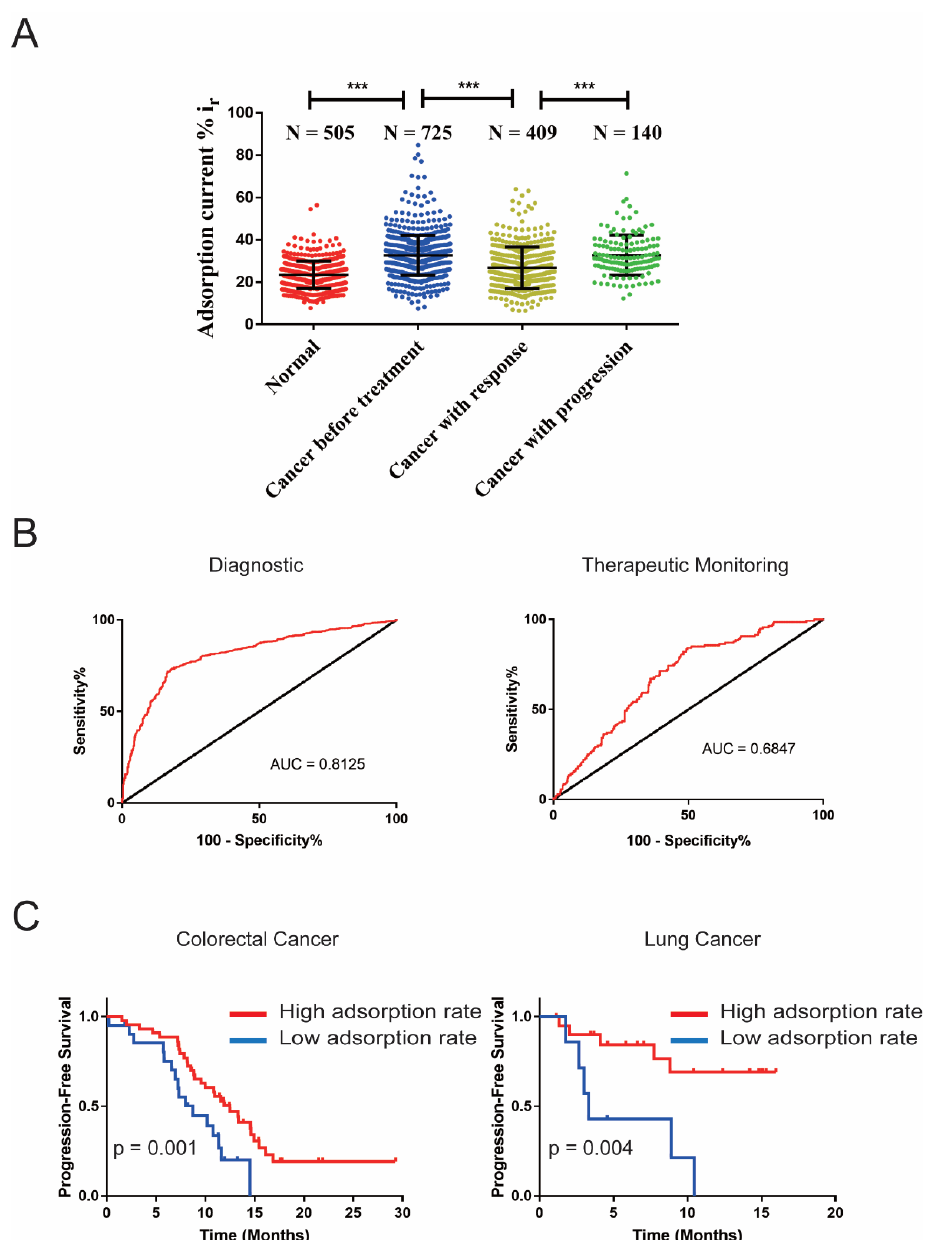
Figure 4. Application of electrochemical methylation detection in malignant tumor diagnosis and prognosis. ( A ) The scatter plot shows the electrochemical detection of the cfDNA adsorption rate from normal people, tumor patients before treatment, tumor patients with response after treatment and tumor patients with progression after treatment. ( B ) The ROC of the cfDNA adsorption rate in the diagnosis and recurrence detection of malignant tumor patients. ( C ) The survival curve shows the progression-free survival time of lung cancer and colorectal cancer patients with high adsorption rates and low adsorption rates. *** p < 0.001.